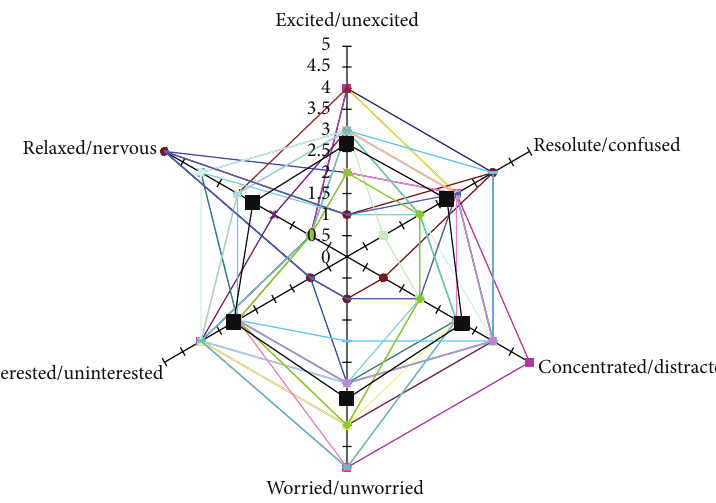
Figure 6: Values of the participants of the learning process